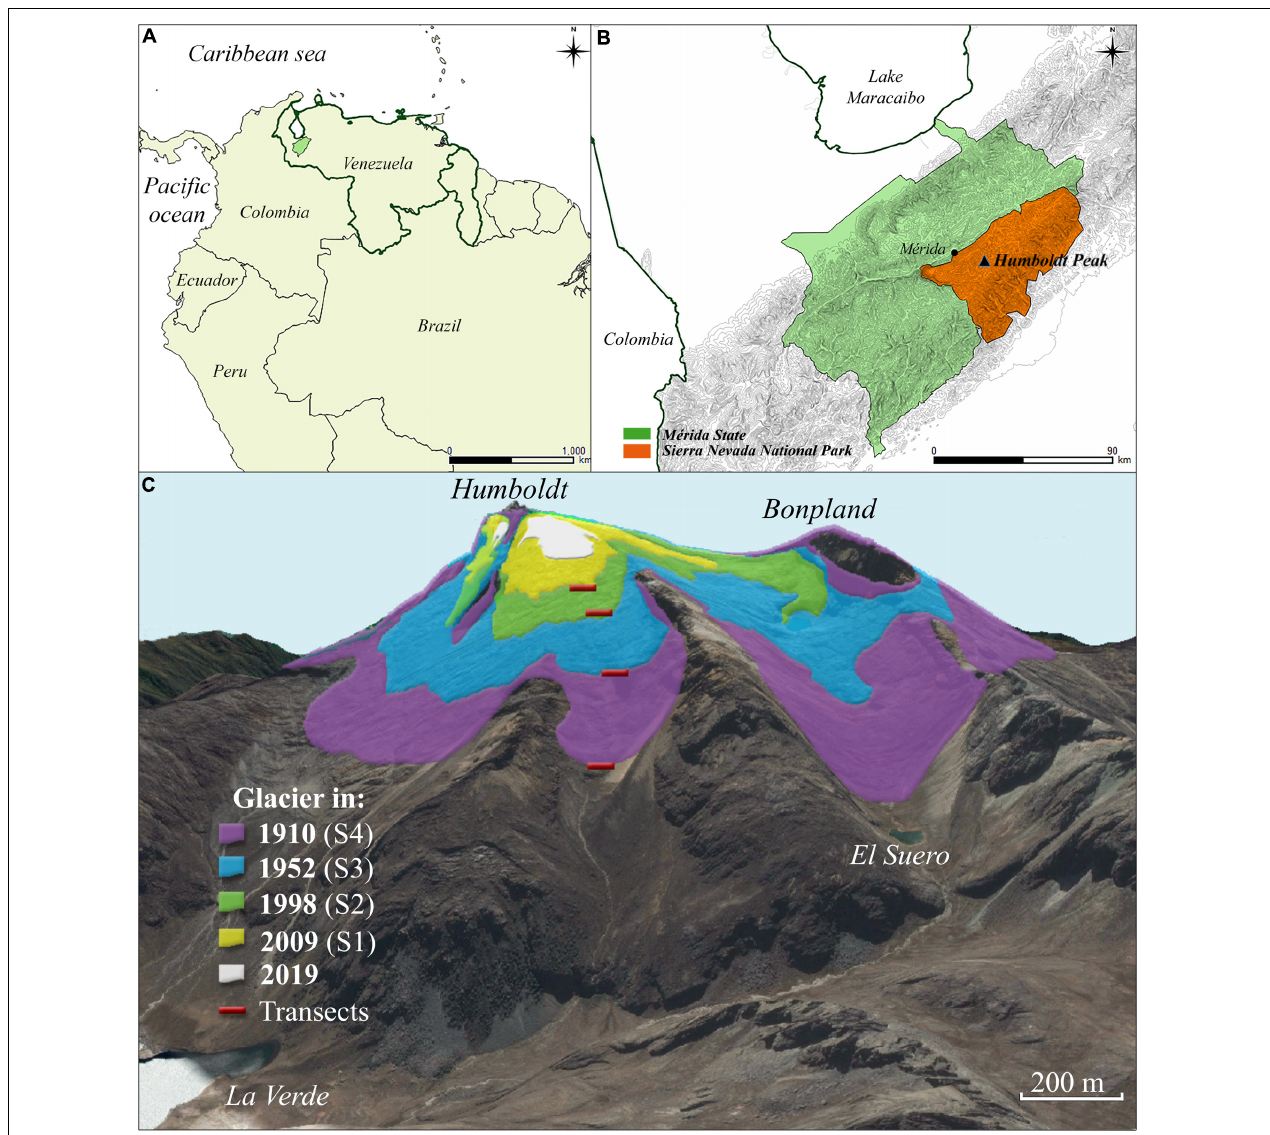
FIGURE 1 | Study region maps. (A) Study region in the northern South America; (B) Detail of Mérida State, the Sierra Nevada National Park and Humboldt Peak, Venezuela. (C) General view of the North West face of Humboldt and Bonpland Peaks indicating the location of our study transects (red lines) and glacier cover for different moments between 1910 and 2020 [based on an integrated historical reconstruction by Ramírez et al. (2020)]. Glacier cover polygons drawn over a Google Earth